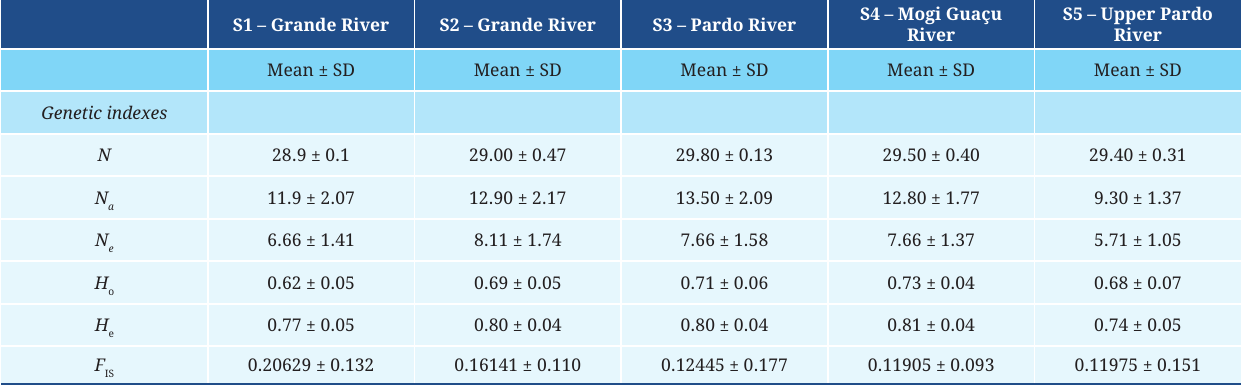
TABLE 2 | Genetic indexes in five sampling sites in the Grande River basin. Different letters indicate significant abiotic differences among sites ( P < 0.05). Number of individuals ( N ), alleles ( Na ) and effective alleles ( Ne ), expected and observed heterozygosity ( He , Ho